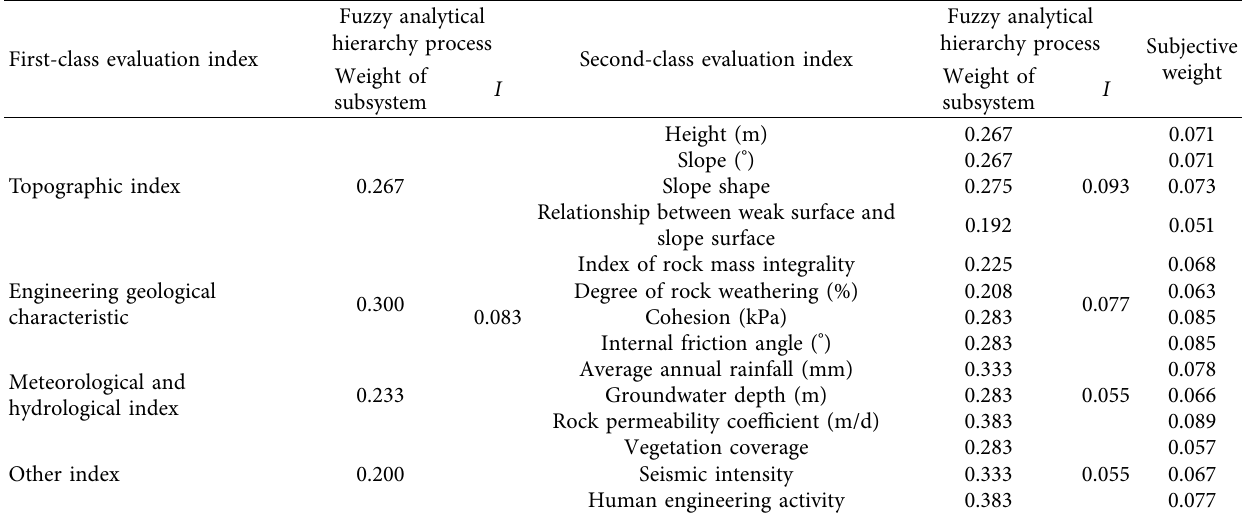
Table 4: Subjective weight of evaluation index and consistency test index of judgment matrix.